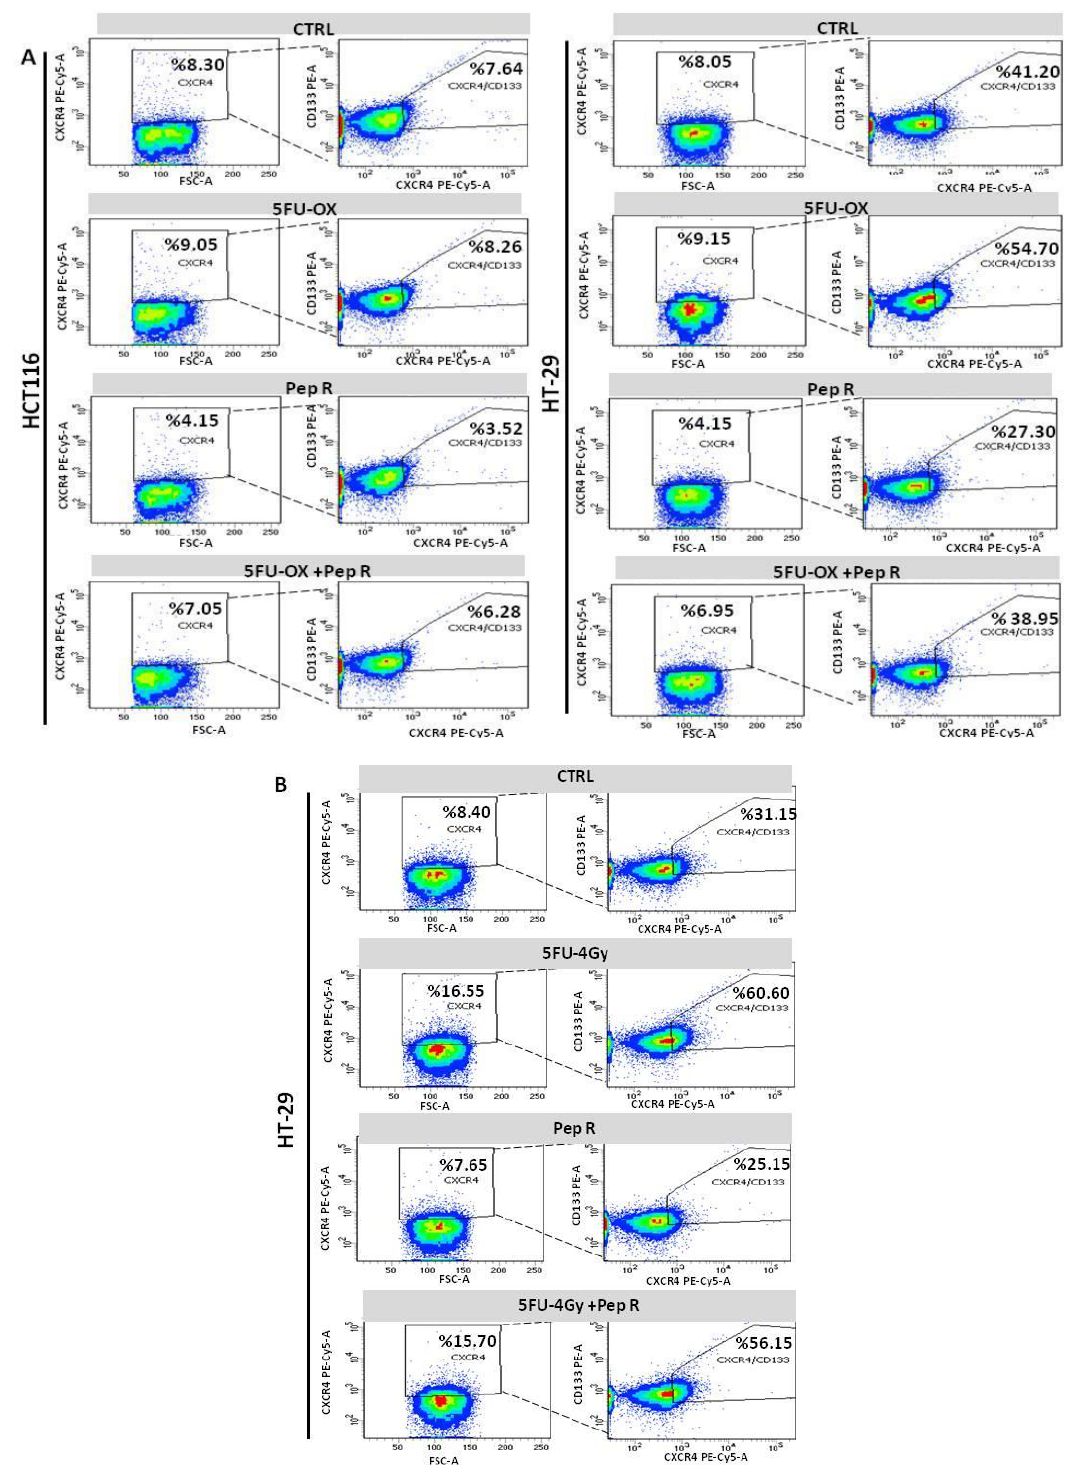
Figure 7. Pep R reduces CXCR4+CD133+ cancer-stem-cell component CT/RT-CT-induced. Flow cytometry analysis for CXCR4 and CD133 expressing cells. HCT116 (left panel) and HT29 (right panel) cells CT treated plus Pep R ( A ) . HT29 RT-CT treated plus CXCR4 plus Pep R ( B ) .